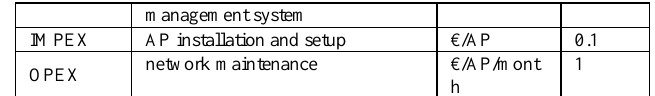
Table A.1: Basic demographics for urban region